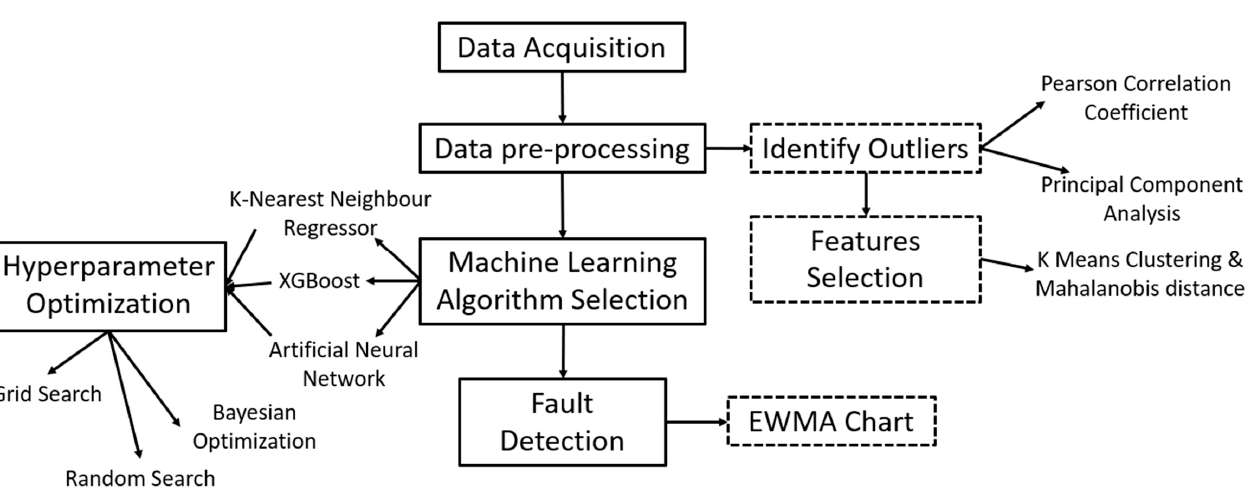
Figure 11. Schematic of Flow Chart of Proposed Condition Monitoring Framework.